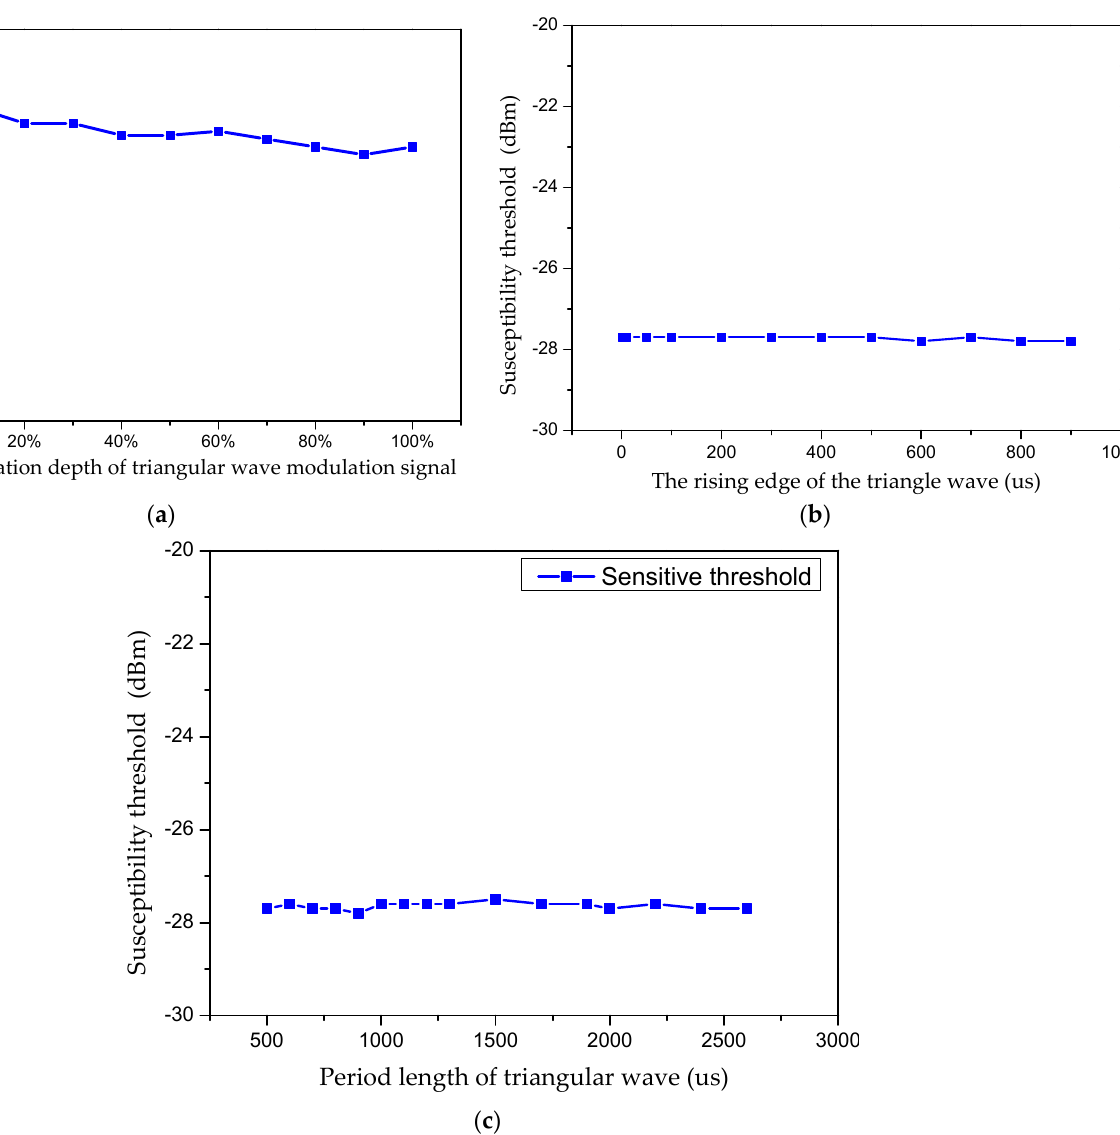
Figure 9. The susceptibility threshold curve of the laser ranging system under triangular wave AM modulation signals: ( a ) under different modulation depths; ( b ) under different rising edge times of triangular wave; ( c ) under different periods of triangular wave.